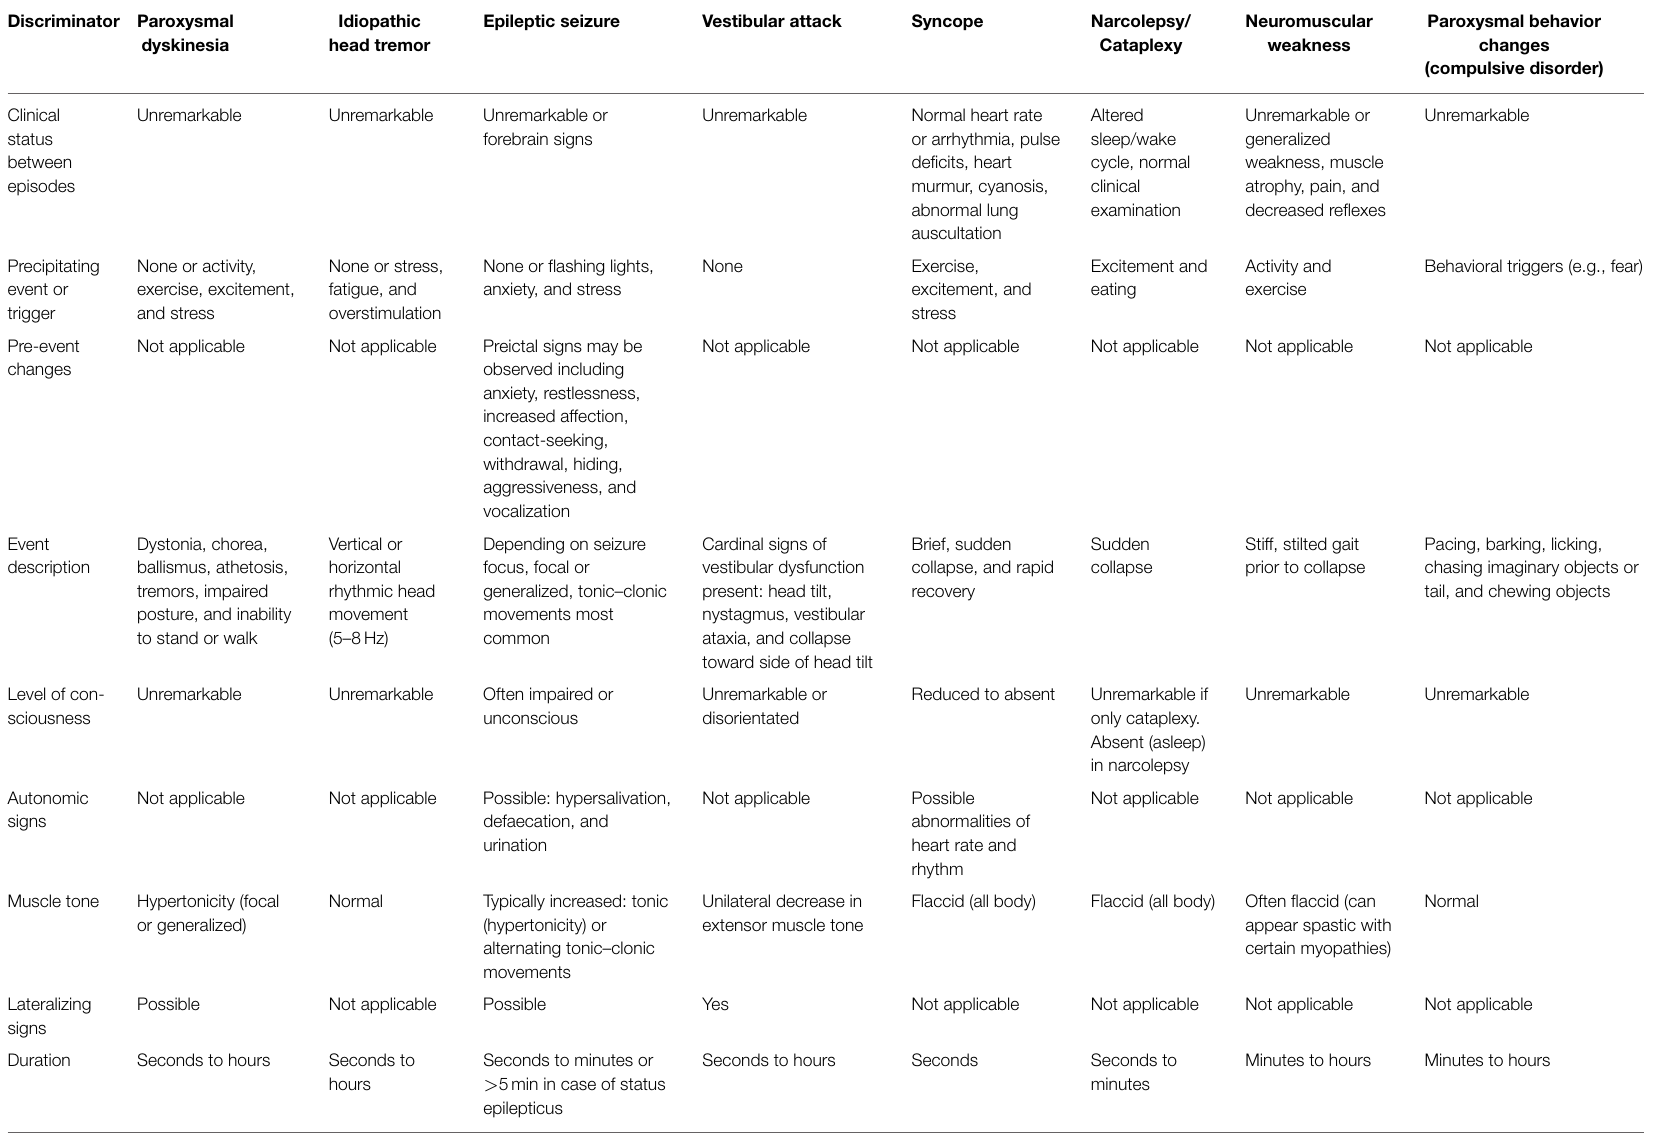
TABLE 3 | Clinical characteristics of episodic disorders in animals